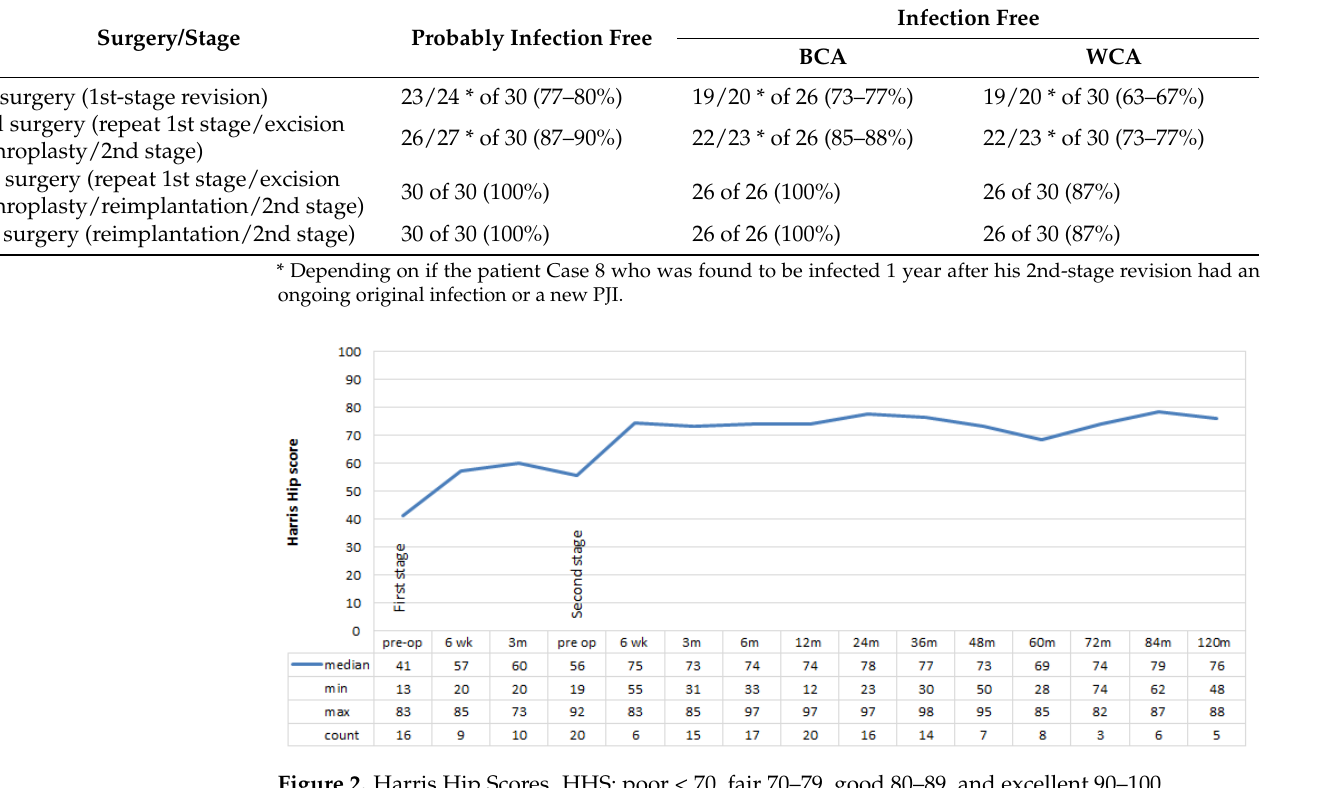
Figure 4. Activity level ratings using the SICOT activity score. SICOT activity: 1 = bedridden/wheel- chair, 2 = sedentary, 3 = semi-sedentary, 4 = light labour, 5 = moderate manual labour, and 6 = heavy manual labour. Similar functional outcomes were reported in patients undergoing either two-stage or multi-staged revisions, with slightly better outcomes of pain and activity in patients having two-stage revisions (Table 6). For the five patients who underwent multi-staged revisions there were improvements in HHS, Pain and activity at 12 months, 24 months and at latest follow up compared to pre-operatively after the first-stage revision. Table 6. Functional outcomes in patients undergoing two-stage or multi-staged revisions by time. HHS (Median, Range)